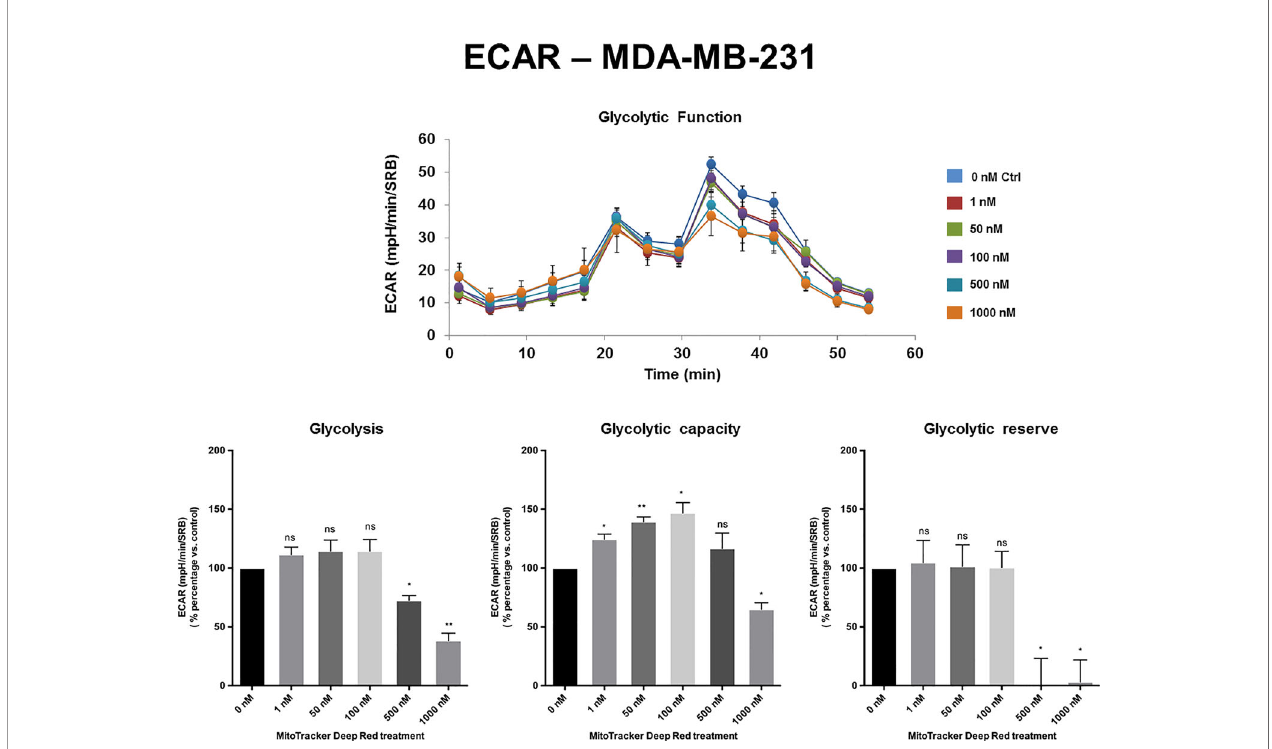
FIGURE 5 | MTDR has minor effects on glycolysis in MDA-MB-231 cells. A representative Seahorse tracing is shown, with bar graphs highlighting the quantitative, dose-dependent effects of MTDR on glycolysis, glycolytic capacity and glycolytic reserve. Note that MTDR has no signi fi cant effect on glycolysis, at concentrations up to 100 nM. Mild to moderate inhibition of glycolysis was only observed, starting at 500 nM. The statistical test used was a one-tail unpaired